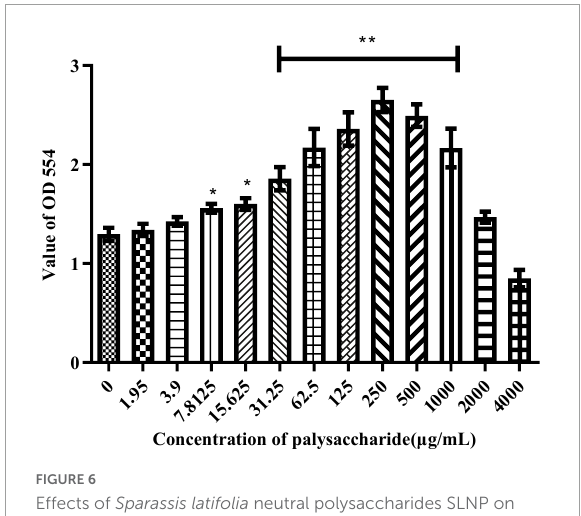
FIGURE6 Effects of Sparassis latifolia neutral polysaccharides SLNP on RAW 264.7 macrophage viabilities. * p < 0.05, ** p < 0.01 vs. control group.